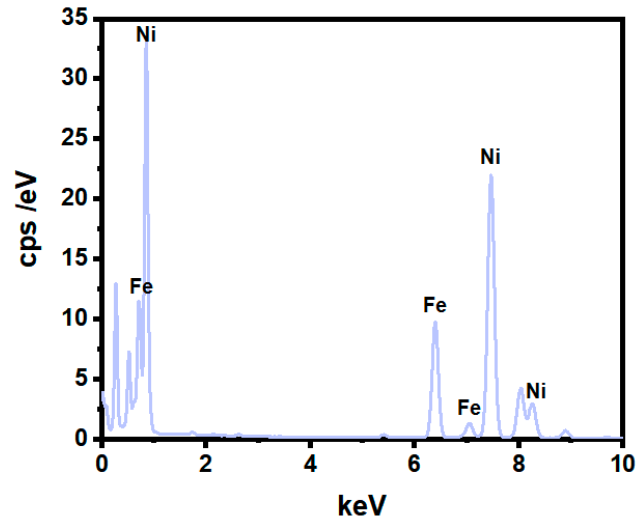
Figure 4. EDX image of FeNi 3 alloy.